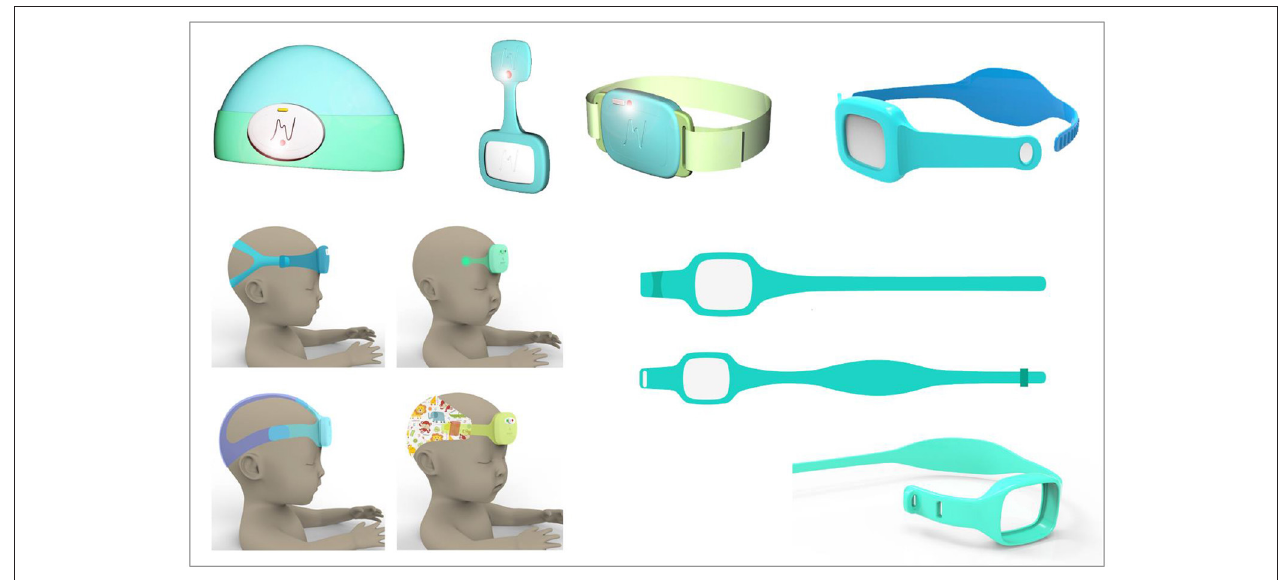
FIGURE 3 | Sampling of neoGuard headband design concepts.